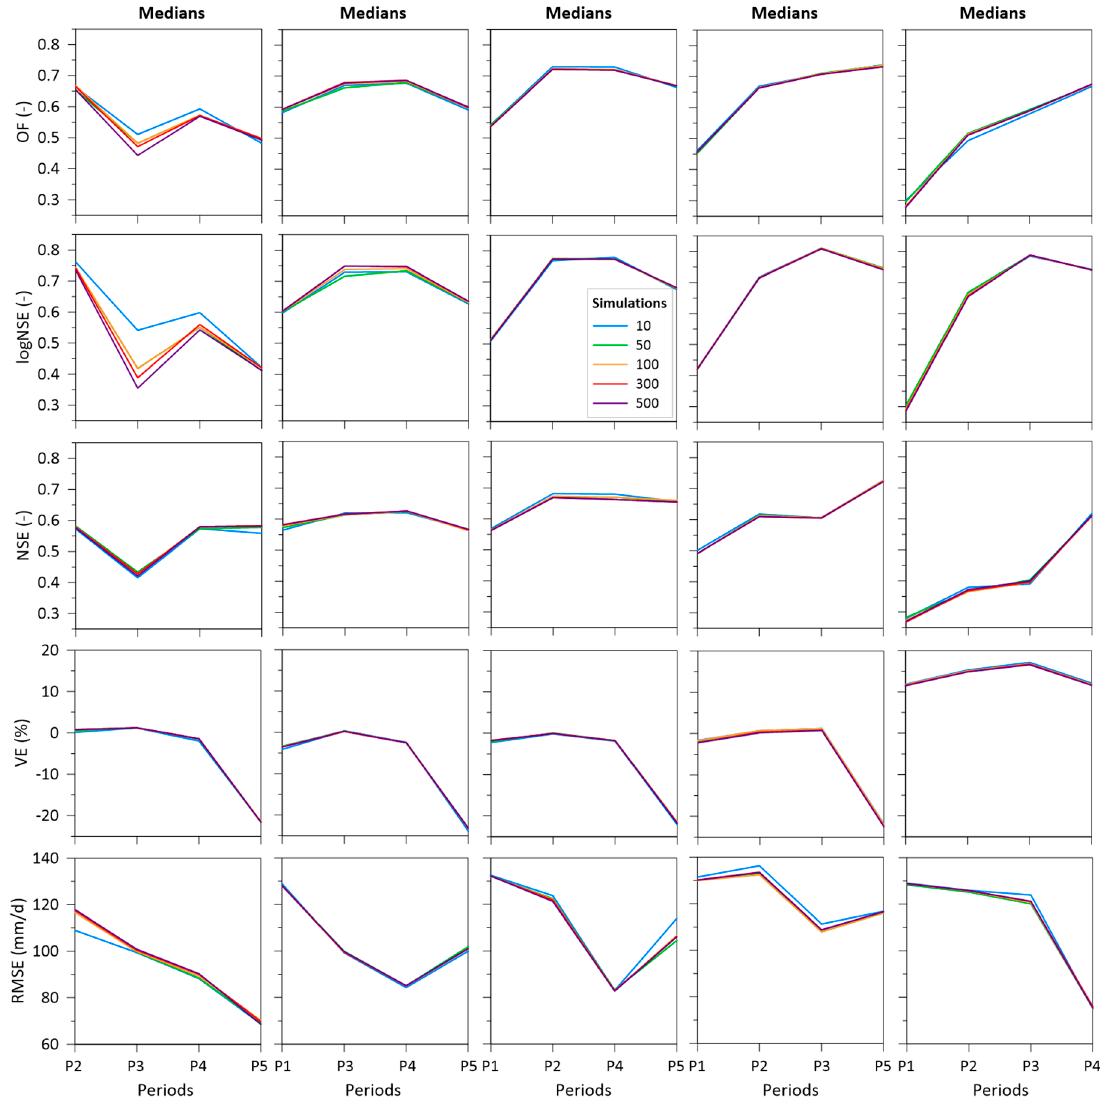
Figure 4. Variability of medians of the objective function (OF), the logarithmic Nash-Sutcliffe efficiency (logNSE), the Nash-Sutcliffe efficiency (NSE) criteria, the root mean square error (RMSE) and the volume error (VE) after 10, 50, 100, 300, 500 repetitions of model simulations in four validation periods. The lines represent the medians of different metrics obtained by the different number of repetitions.